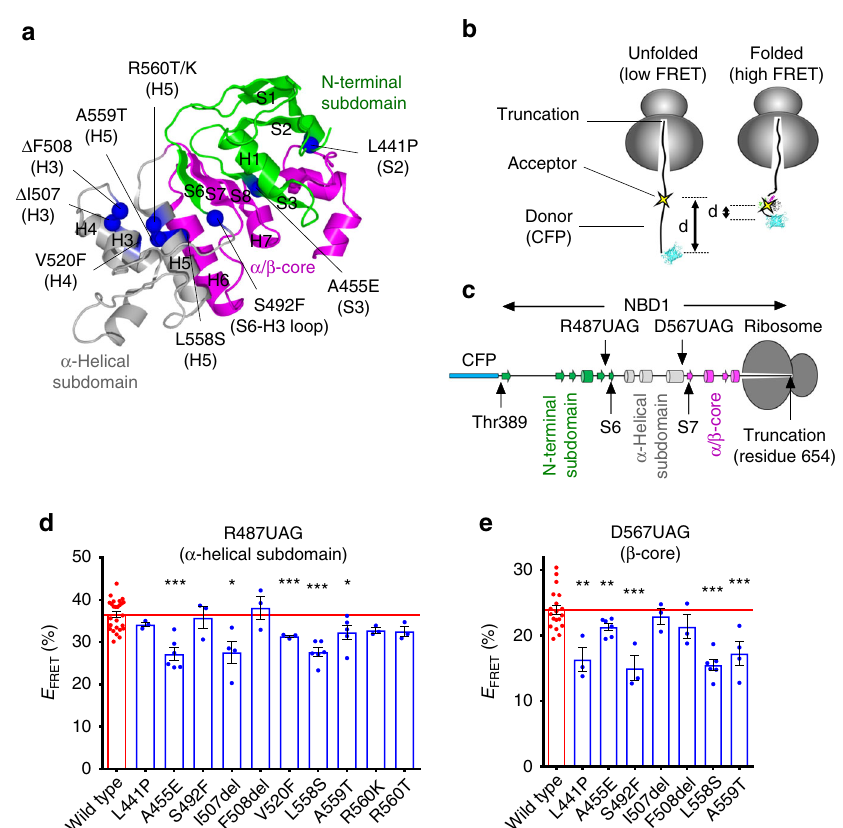
Fig. 1 CF-causing mutations perturb NBD1 biosynthetic intermediates. a Location of CFTR processing mutations shown in the NBD1 structure taken from the human CFTR Cryo-EM structure (PDB: 5UAK). b Cartoon conceptually depicting FRET assay using translationally incorporated fl uorophores to detect structural transitions of ribosome-attached nascent polypeptides. c Schematic of ribosome-attached CFP-NBD1 fusion protein truncated at CFTR residue 654 showing locations of FRET acceptor dye at CFTR residues Arg487, or Asp567, which report folding of the α -helical subdomain, or β -sheet core, respectively 17,18 . Helices and β -strands are drawn as cylinders and fi lled arrows, respectively. d , e FRET ef fi ciencies obtained for wild-type and mutant nascent polypeptides in (ribosome-attached) CFP-NBD1 constructs truncated at residue 654 and containing acceptor dye at residue Arg487 d or Asp567 e . Each dot represents data from an independent experiment. Each bar shows mean ± SEM, n ≥ 3 independent experiments. Two-tailed student ’ s t test comparing wild-type and indicated mutant, asterisk p < 0.05, double asterisk p < 0.01, triple asterisk p < 0.001, n.s. > 0.05 otherwise indicated. Red line shows mean of FRET ef fi ciency for wild-type. Source data of d and e are provided as a Source Data fi